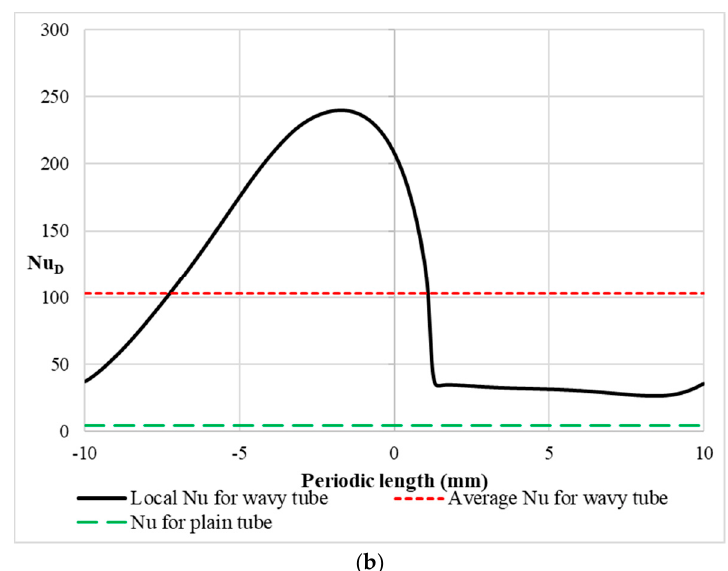
Figure 10. Local Nusselt number across wavy-walled tube ( a ) F w = 0.58 and Re D = 100 (Laminar) and ( b ) F w = 0.58 and Re D = 1000 (Turbulent).